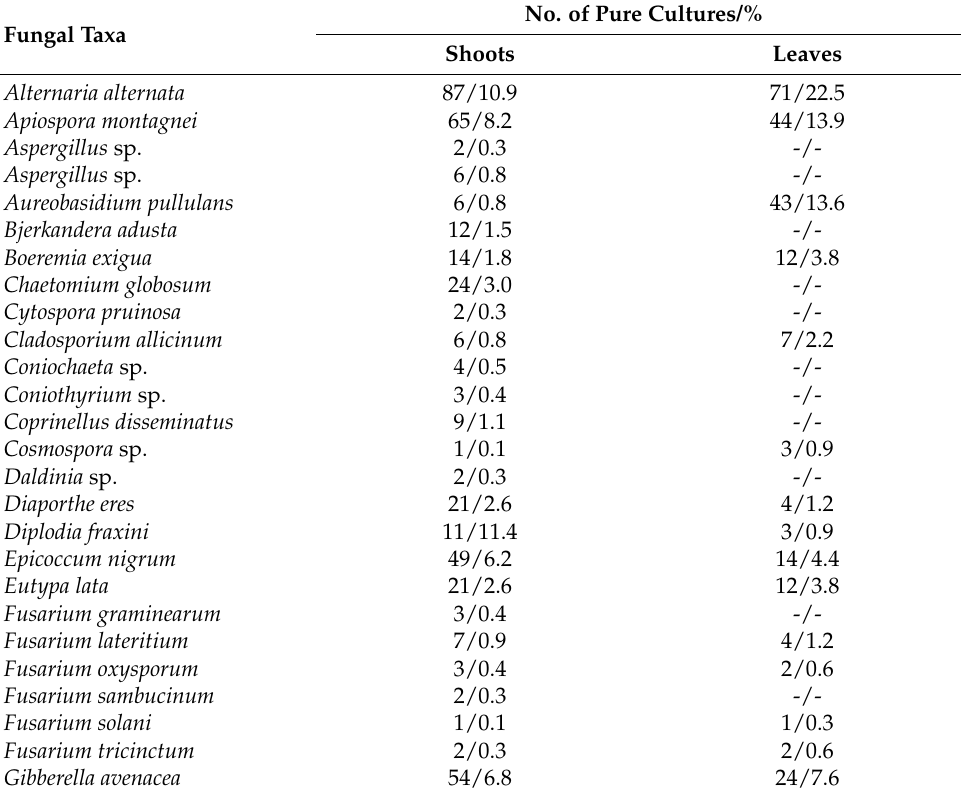
Table 2. Frequencies of fungi isolated from shoots and leaves of F. excelsior. Fungal